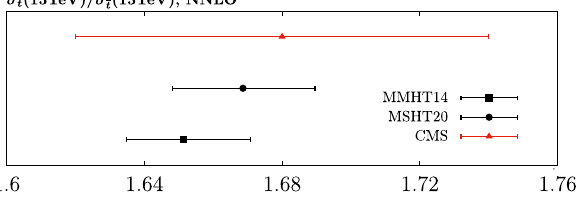
Fig. 86 MMHT14 and MSHT20 NNLO predictions for the ratio of t to t total cross sections at 13 TeV, compared to the CMS measurement